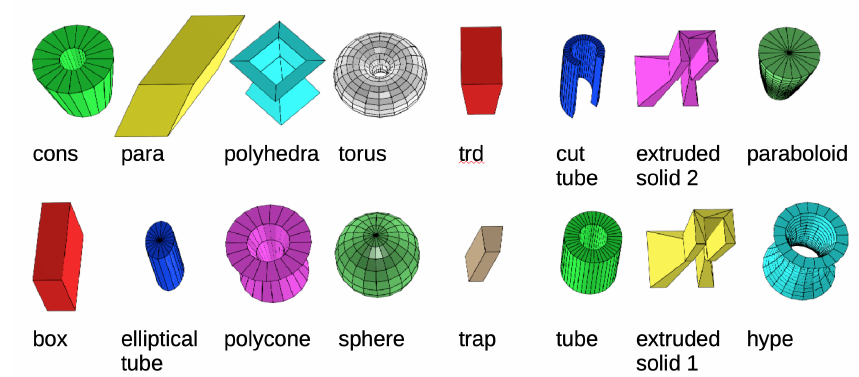
Figure 3. Overview of solids supported in